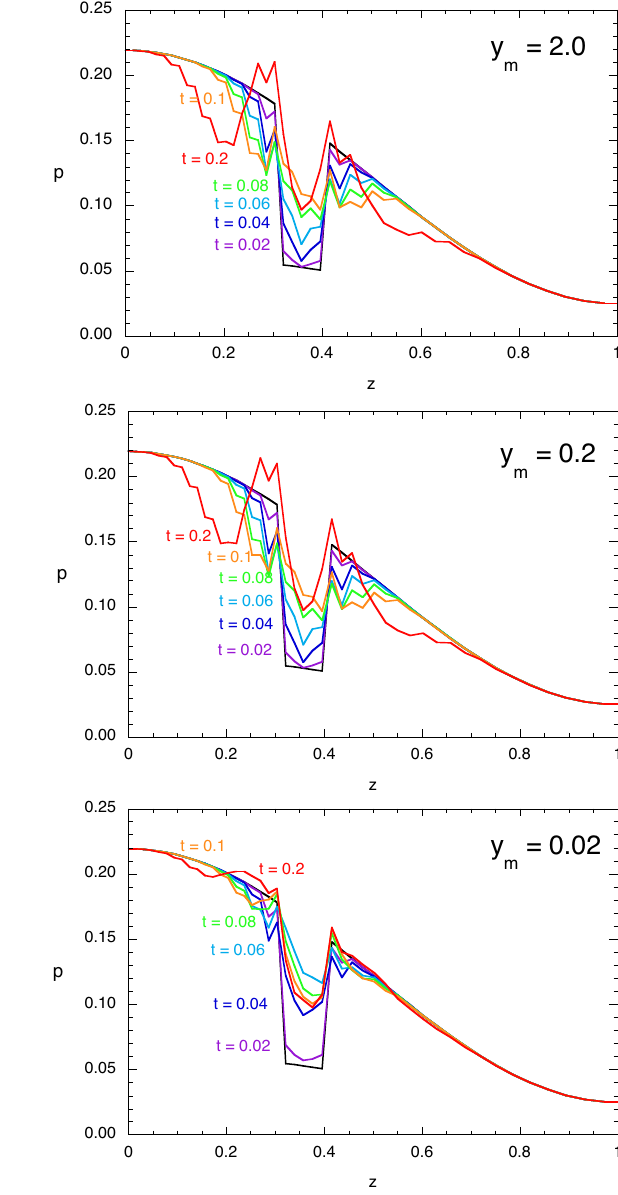
Fig. 3. Plasma pressure at x =− 5 . 7 ,y = 0 as a function of z at dif- ferent times and for 3 different bubble widths, as